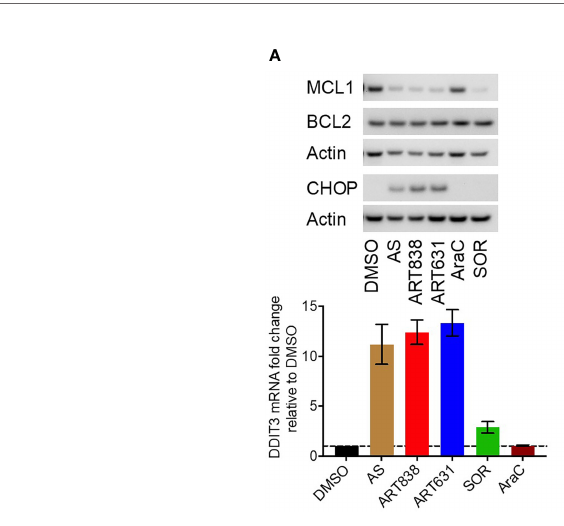
FIGURE 5 | ART631 elevated ROS and CHOP levels and reduced MCL1 expression in MV4;11 and ML2 AML cells. (A) MV4;11 cells (left) and ML2 cells (right) were treated for 18h with vehicle, AS (10 uM), ART838 (200 nM), ART631 (200 nM), cytarabine (AraC; 150 nM), or SOR (5 uM). Protein was isolated and western blotted for MCL1, BCL2, CHOP, and b -actin. (B) MV4;11 cells (left) and ML2 cells (right) were treated as in (A) for 18h, total RNA isolated, cDNA synthesized, and SYBR Green qRT-PCR performed. Ct values were normalized to housekeeping gene GAPDH and fold change shown relative to vehicle (DMSO) control. Error bars represent SD from 3 independent experiments done in triplicate. ML2 cell data is from one experiment done in triplicate.